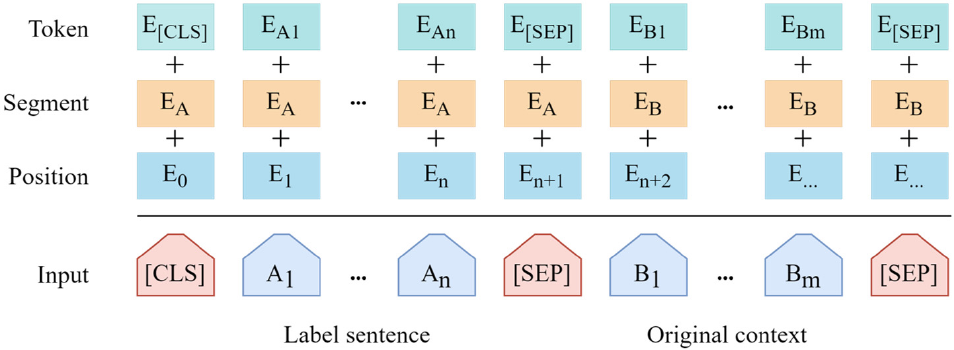
Figure 3. The structure of label